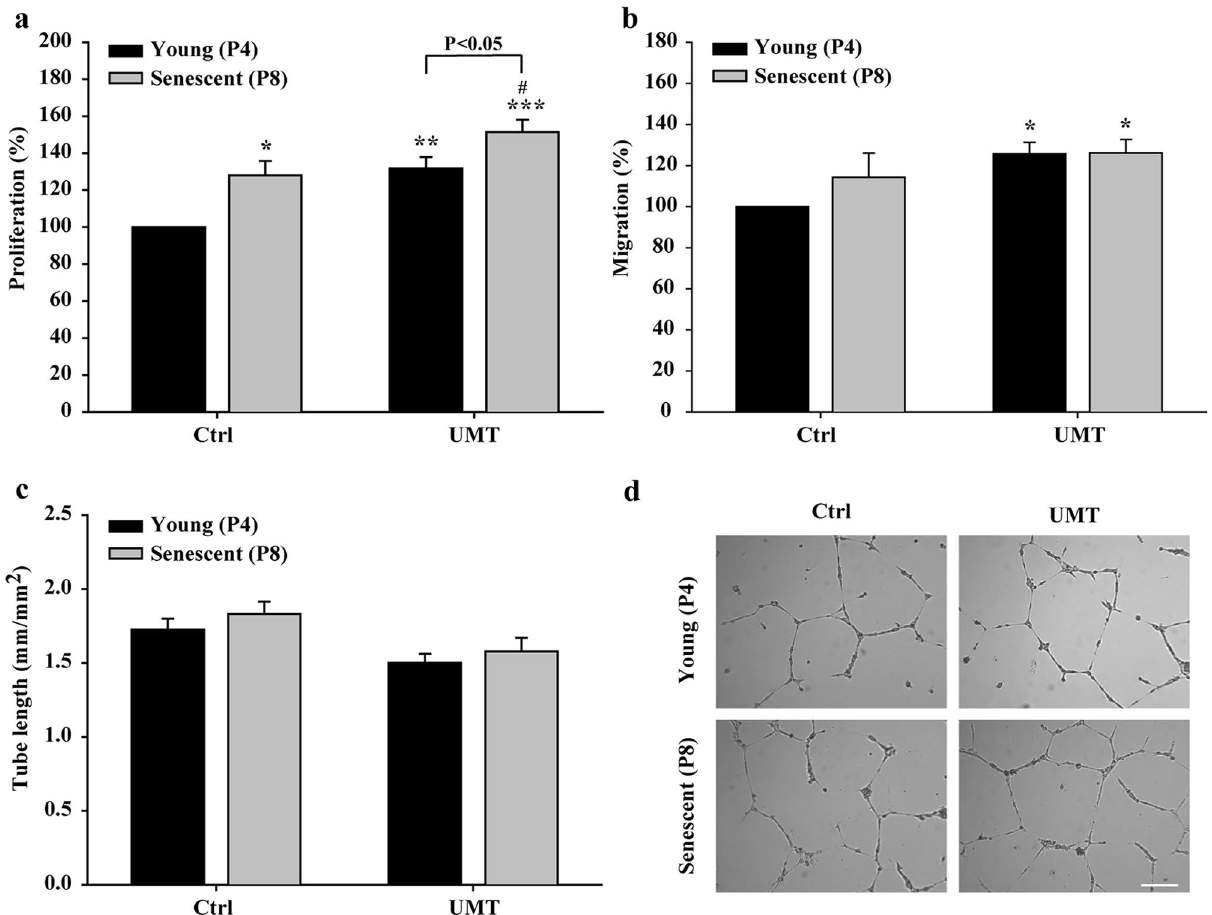
Figure 6. Effects of supernatants (1000 μl/well) from young and senescent porcine EPCs 48 h post UMT- mediated VEGF transfection on the proliferation ( a ), migration ( b ) and tube formation ( c ) of human aortic endothelial cells. ( d ) Representative micrographs of tube formation in the different groups are shown. Scale bar: 250 µm. Proliferation was evaluated using a BrdU incorporation assay. Migration and tube formation were analysed with Leica QWin image analysis software (Cambridge, UK, version number: V3.5.2). n = 7 for each bar. In a , b and c : * P < 0.05; ** P < 0.01; *** P < 0.001 vs. the leftmost black bar and # P < 0.05 vs. the leftmost grey bar. Note that for the UMT groups, differences between the grey and black bars are indicated. All abbreviations are the same as those used in Fig.